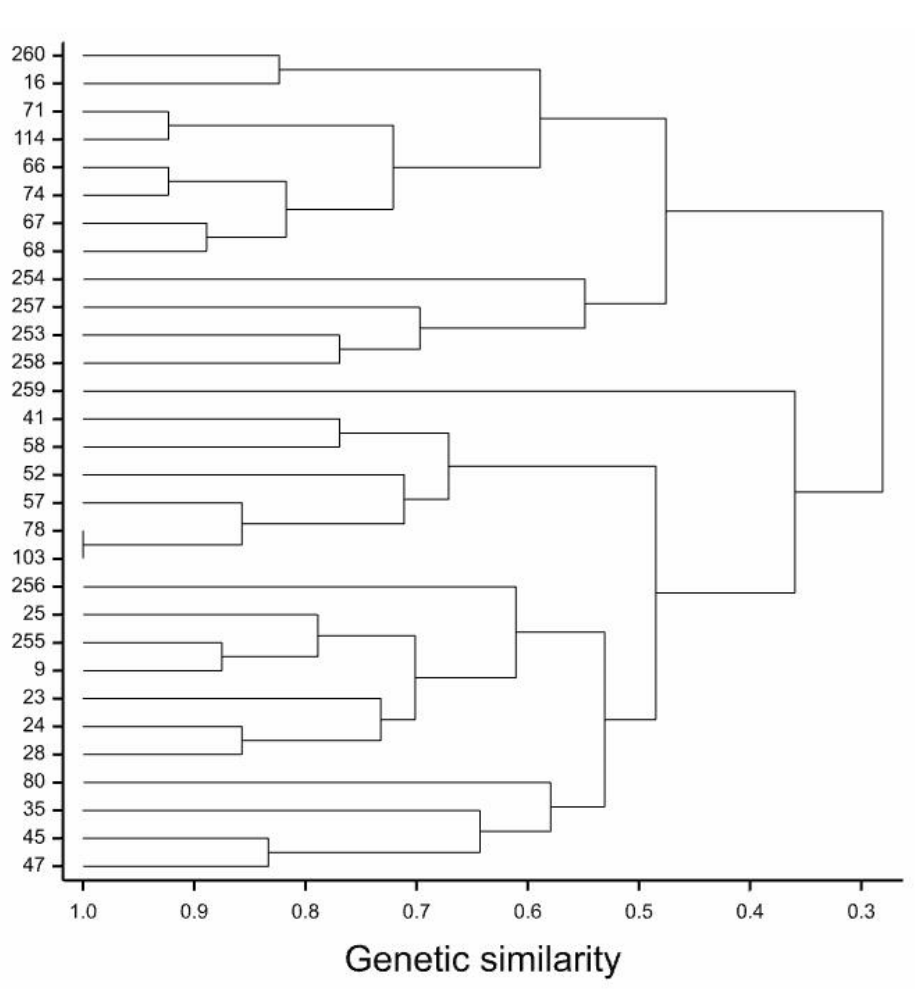
Figure 5. Dendrogram of cluster groupings of 30 maize lines based on all molecular markers.